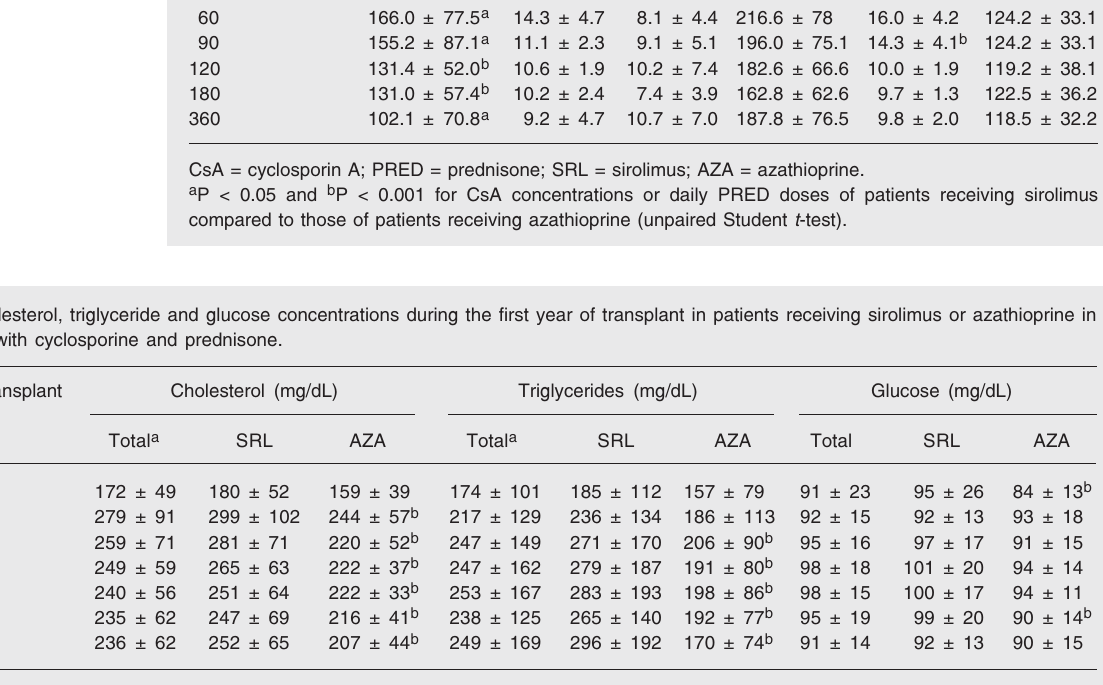
SRL = sirolimus; AZA = azathioprine. a P < 0.05 for the comparison of mean cholesterol or triglyceride concentrations between day 0 and day 360. b P < 0.05 for cholesterol, triglyceride or glucose concentrations determined at individual study visits for patients receiving SRL vs AZA (unpaired Student